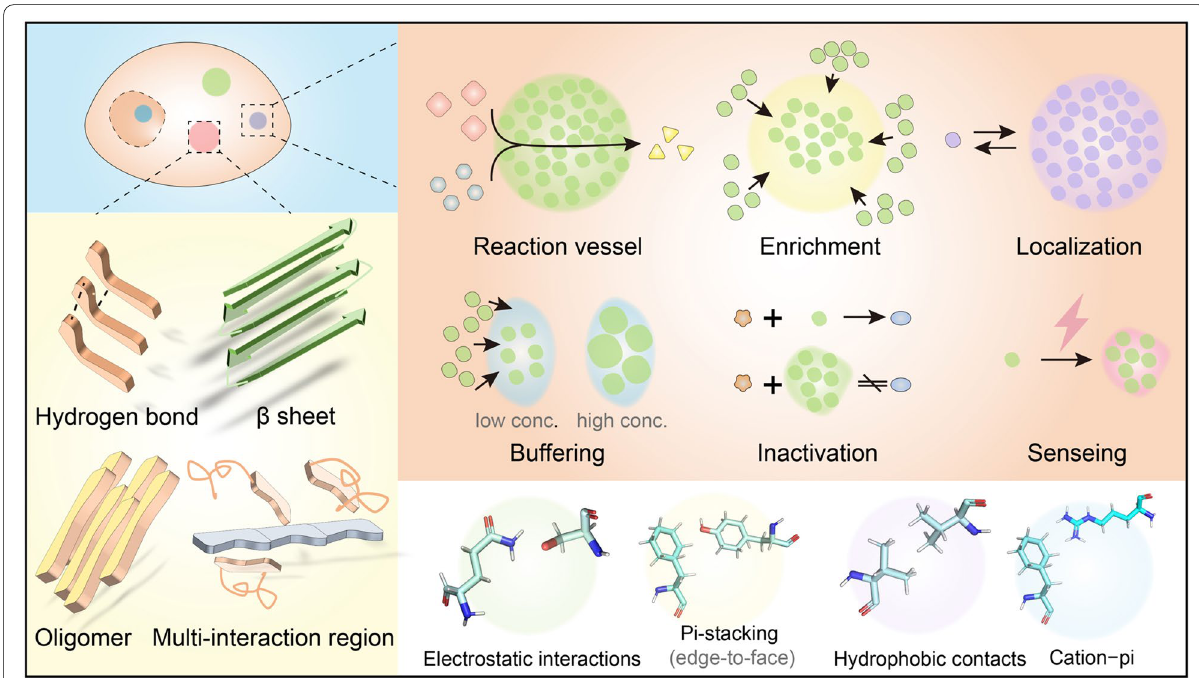
Fig. 1 Function of LLPS and forces that drive it. LLPS has been found to be involved in a variety of physiological processes, which can be divided according to their functions, including reaction vessel, enrichment, localization, buffering, inactivation, and sensing. Weak, transient, and short-ranged interactions, including electrostatic interactions, π-stacking, hydrophobic contacts, and cation-π interactions, are the basic driving forces of LLPS. Covalent or strong intermolecular interactions and secondary structures, including the hydrogen bond, β-sheet, oligomer, and multi-interaction region, also contribute to